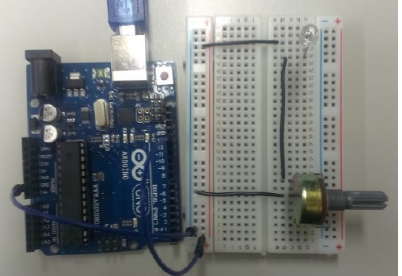
Figure 3. The Arduino board and the LED lamp used in our system.